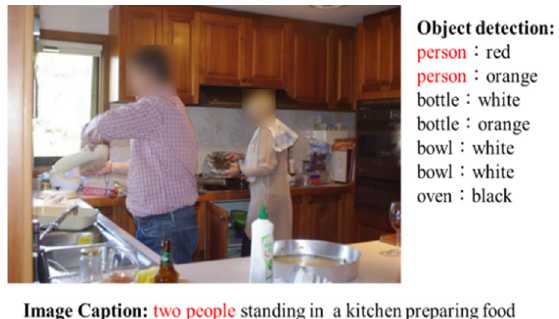
Figure 16. Image captioning result of an image containing two similar objects.